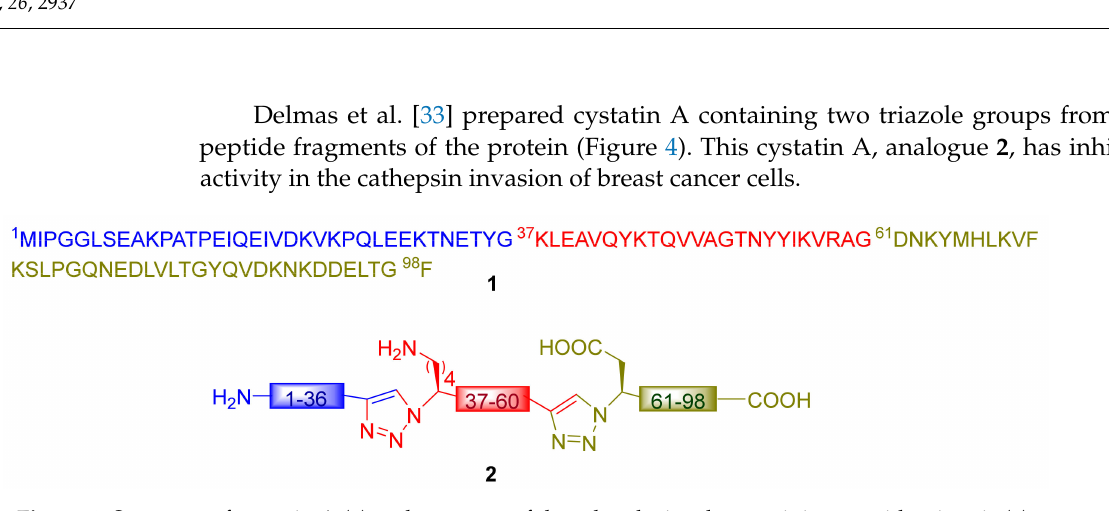
Figure 4. Sequence of cystatin A ( 1 ) and structure of the related triazole containing peptidomimetic ( 2 ).